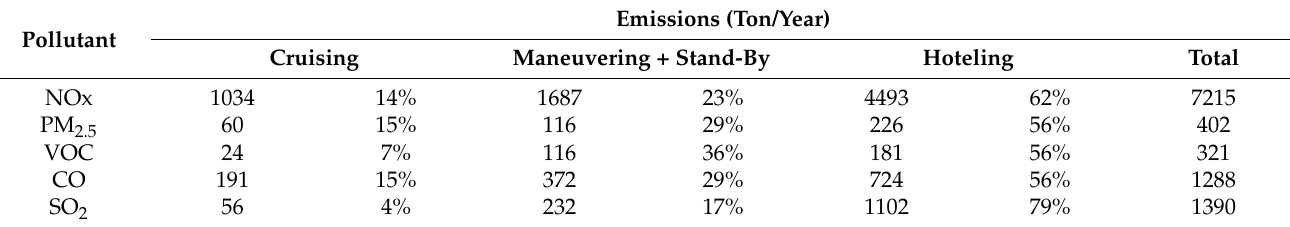
Table A19. Total emissions from vessels (Ashdod, BAU 2025).